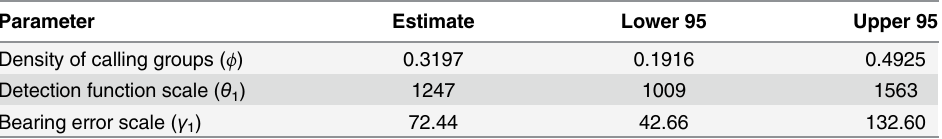
Table 1. Results of the case study analysis. Parameter estimates and parametric bootstrap intervals for the preferred model. Density units are the number of calling groups km − 2 and the units of the detection func- tion scale parameter θ 1 are in